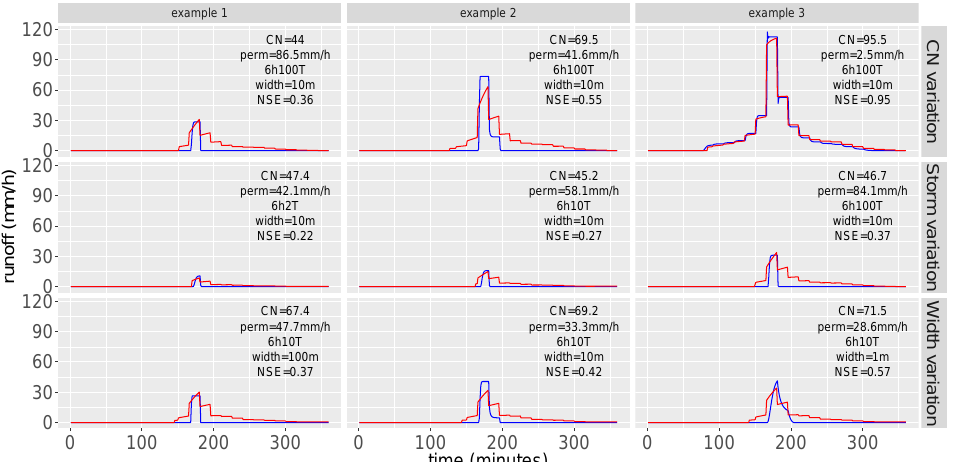
Figure 6. Nine examples of SCS-CN hydrographs, used as a baseline (red), and fitted LID hydrographs (blue). For each pair, baseline CN, calibrated pavement permeability, storm, width, and NSE are